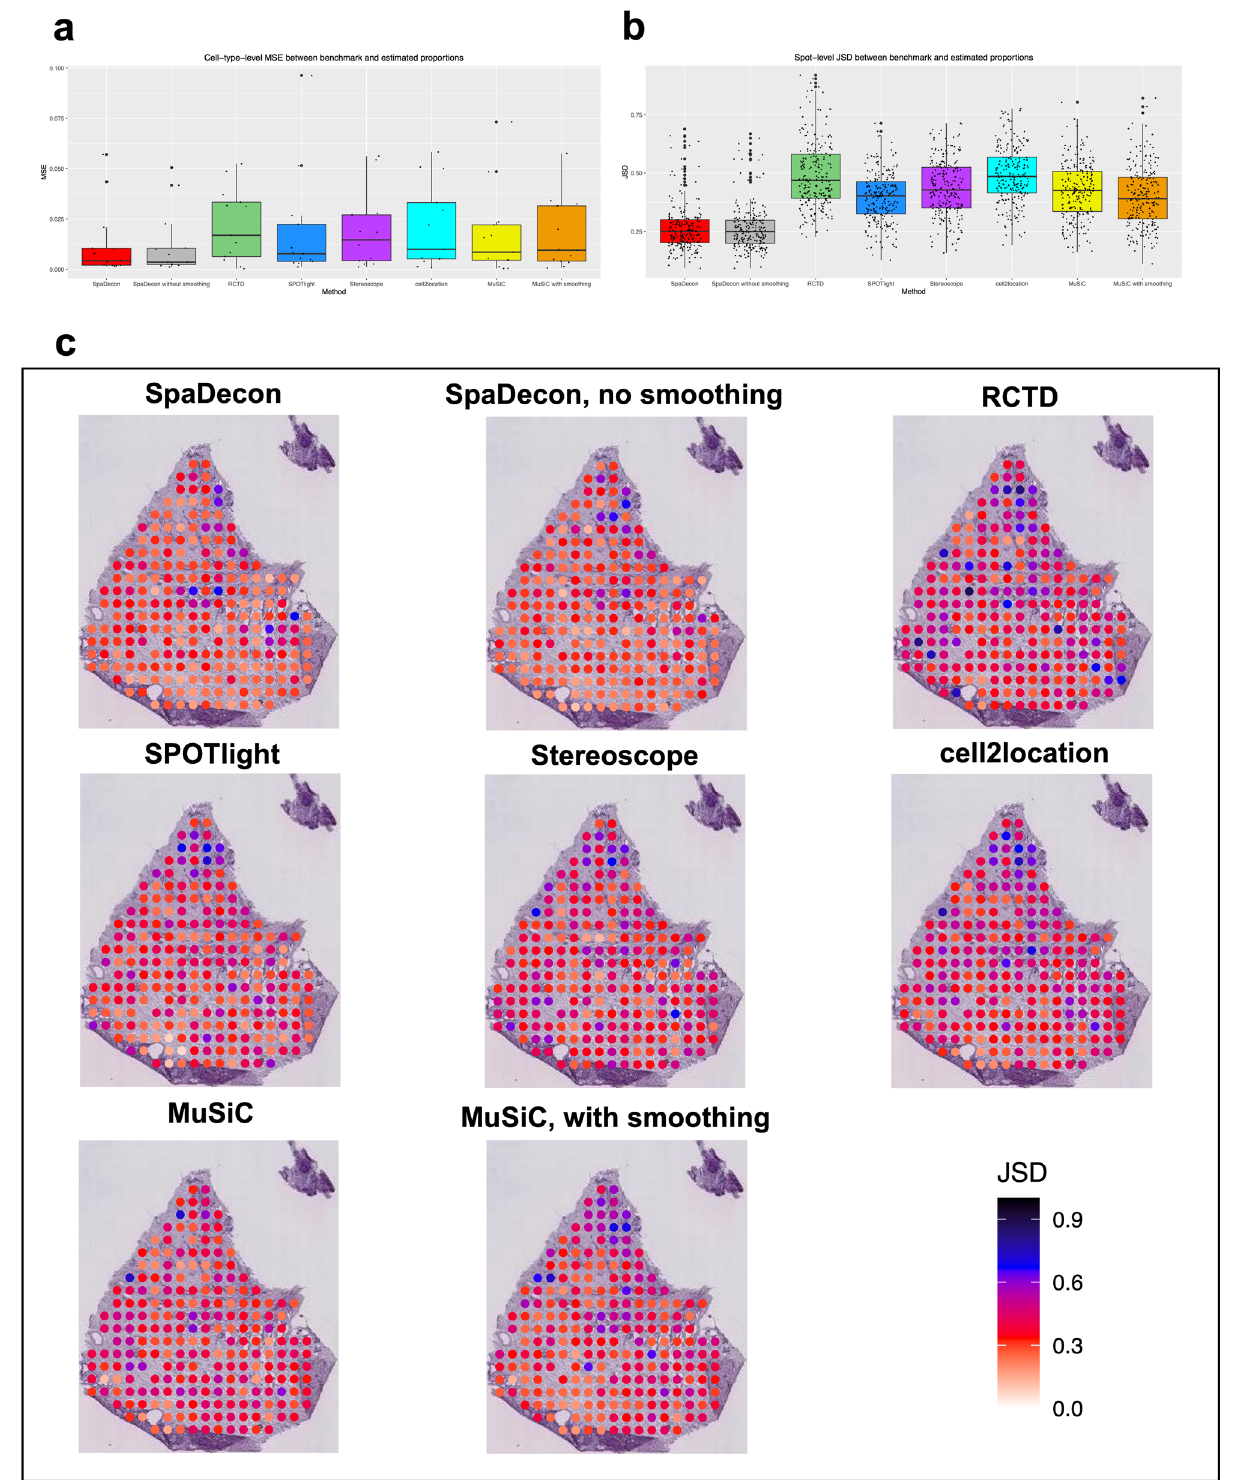
Fig. 6 Pancreatic ductal adenocarcinoma ST benchmark evaluations. a Boxplot showing the mean squared error between the benchmark and estimated proportions across all cell types for each method ( n = 13 cell types). b Boxplot showing the Jensen-Shannon divergence between the benchmark and estimated proportions across all spots for each method ( n = 24 spots). c Heatmaps showing the Jensen-Shannon divergence between the benchmark and estimated proportions at each spot in the pseudo-SRT dataset for each